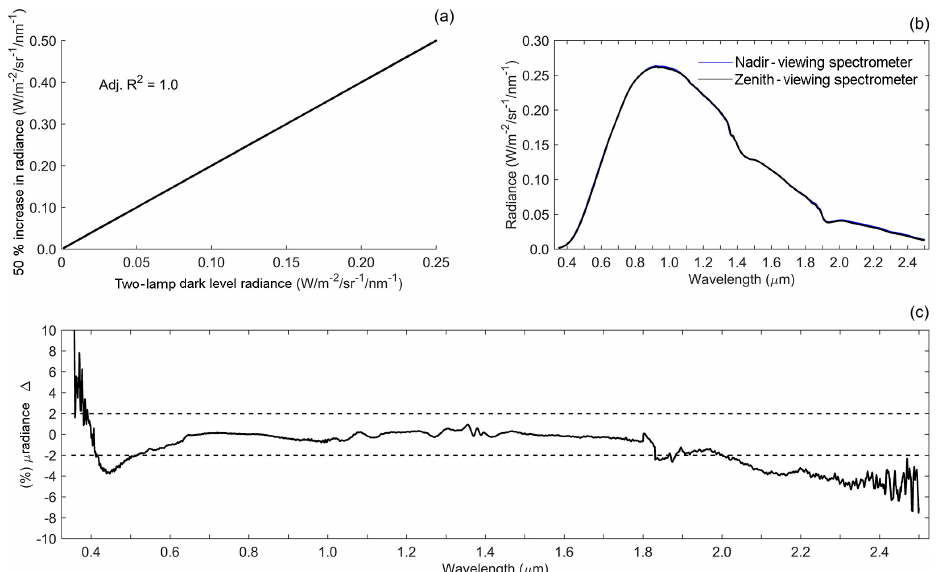
Figure 2. Laboratory cross-calibration of the nadir- and zenith-viewing spectrometers using the NIST-traceable source. Panel (a) shows the zenith-viewing spectrometer linearity test result, and panel (b) shows the cross-calibration using the NIST-traceable-source output. Panel (c) summarizes the difference in response between nadir- and zenith-viewing spectrometers relative to the achieved stability requirement (dotted lines).